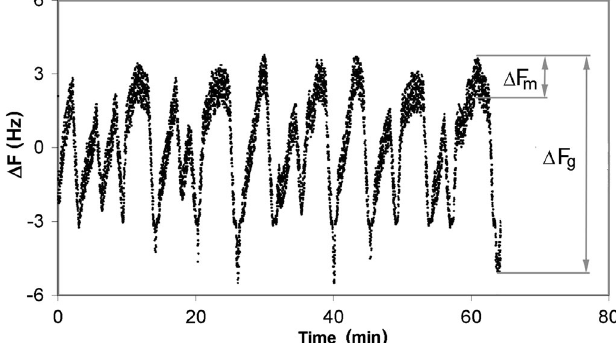
FIG. 5. The dependence of bunch phase advance Δ Ψ as a FIG. 6. Time dependence of the instantaneous resonance det function of bunch relative energy change Δ E=E as per Eq. (7). frequency deviation Δ F from the reference frequency of the The numbers in brackets corresponds to vertical axis scaled down unlocked SLR at 4.2 K in the ambient cryostat by a factor of 10. The parameter k is shown as a number next to the right vertical axis. The two solid lines with arrow heads show graphically how to determine Δ Ψ if parameters Δ E=E and k det are known. The two dashed lines with arrow heads illustrate how to define Δ E=E if the parameters Δ Ψ and k are identified. det